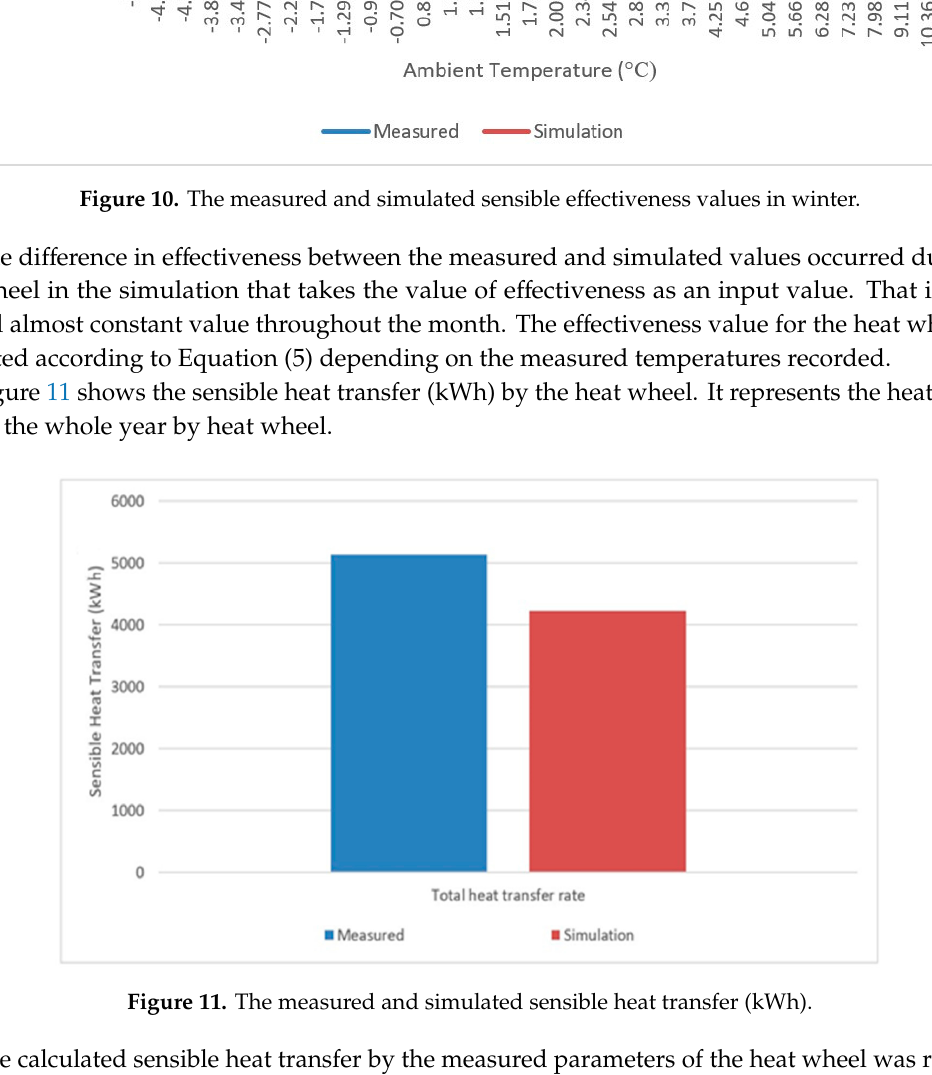
Figure 10. The measured and simulated sensible effectiveness values in winter.